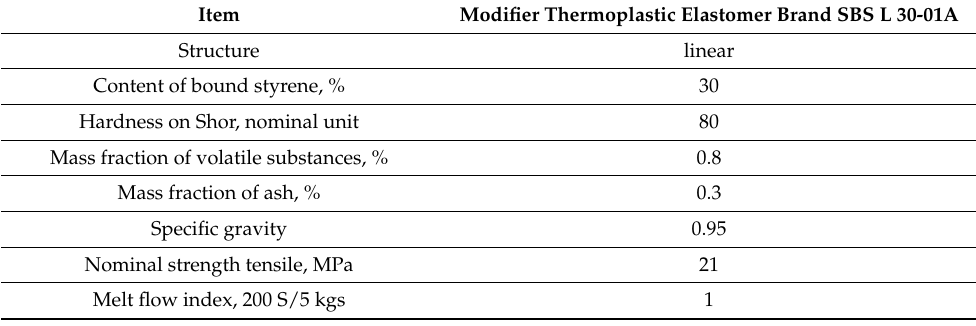
Table 2. Characteristics of reagents for preparation of modified bitumen